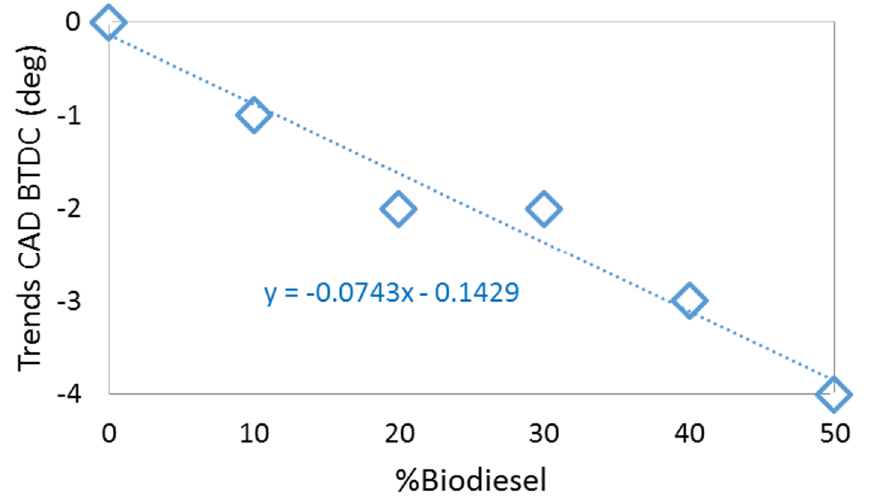
Figure 19. Trending injection timing follows biodiesel